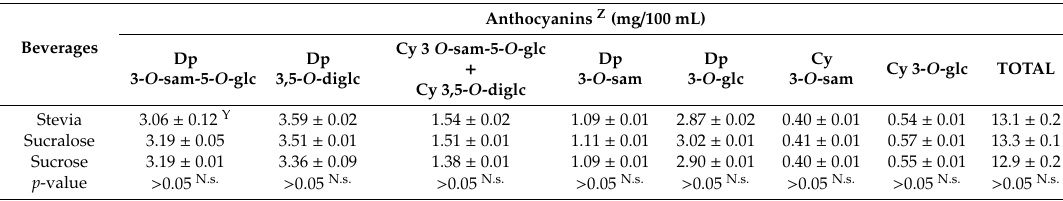
Table 1. Anthocyanins composition of the maqui-citrus